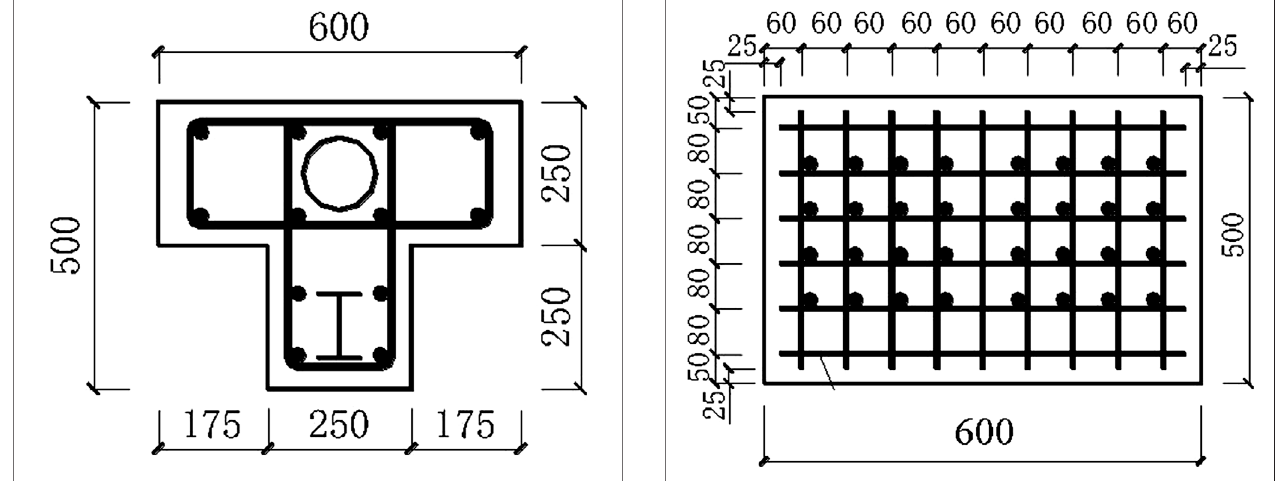
FIGURE 4 | Reinforcement of column capital.